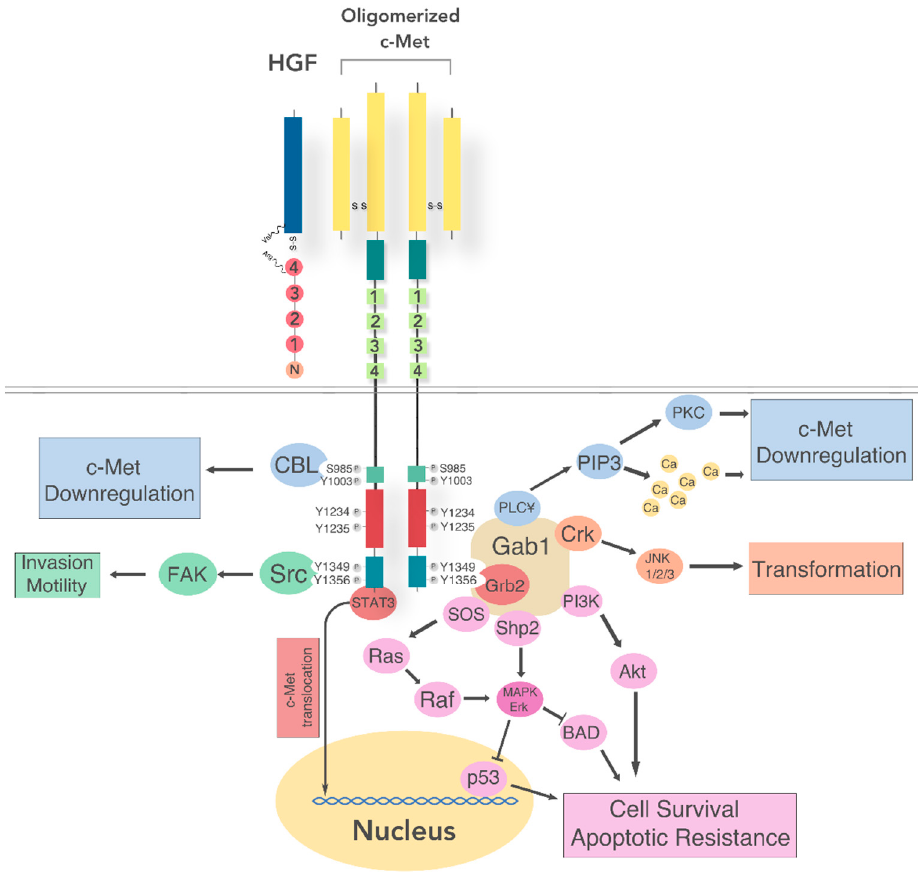
Figure 2. Hepatocyte growth factor (HGF) binding c-Met activates signaling cascades including Src, CT10 (chicken tumor virus no.10) regulator of kinase (Crk), mitogen-activated protein kinase/ extracellular signal-regulated kinases (Mapk/Erk), and phosphotidylinsitol-3-OH kinase (PI3K), leading to loss of tumor cell apoptosis, survival, transformation, invasion, and motility. Downregulation of c-Met are highlighted in blue. c-Met signaling that promotes cell survival and apoptotic resistance are highlighted in lavender. c-Met signaling that promotes transformation is highlighted in orange. c-Met signaling that promotes invasion and motility is highlighted in green. CBL: casitas B-lineage lymphoma; FAK: focal adhesion kinase; STAT3: signal transducer and activator of transcription-3; PKC: protein kinase c; PIP3:phosphatidylinositol (3,4,5)-trisphosphate; PLC: phospholipase C; JNK: jun n-terminal kinase; Gab1: Grb2-associated adaptor protein; Grb2: growth factor receptor-bound protein 2; Akt: alpha serine/threonine-protein kinase; SOS: Ras guanine nucleotide exchange factor son-of-sevenless; Shp2: Src kinase, and Src homology region-2 containing protein tyrosine phosphatase 2; Ras: rat sarcoma; Raf: rapidly accelerated fibrosarcoma; BAD: Bcl-2 associated death promoter; p53: cellular tumor antigen p53.